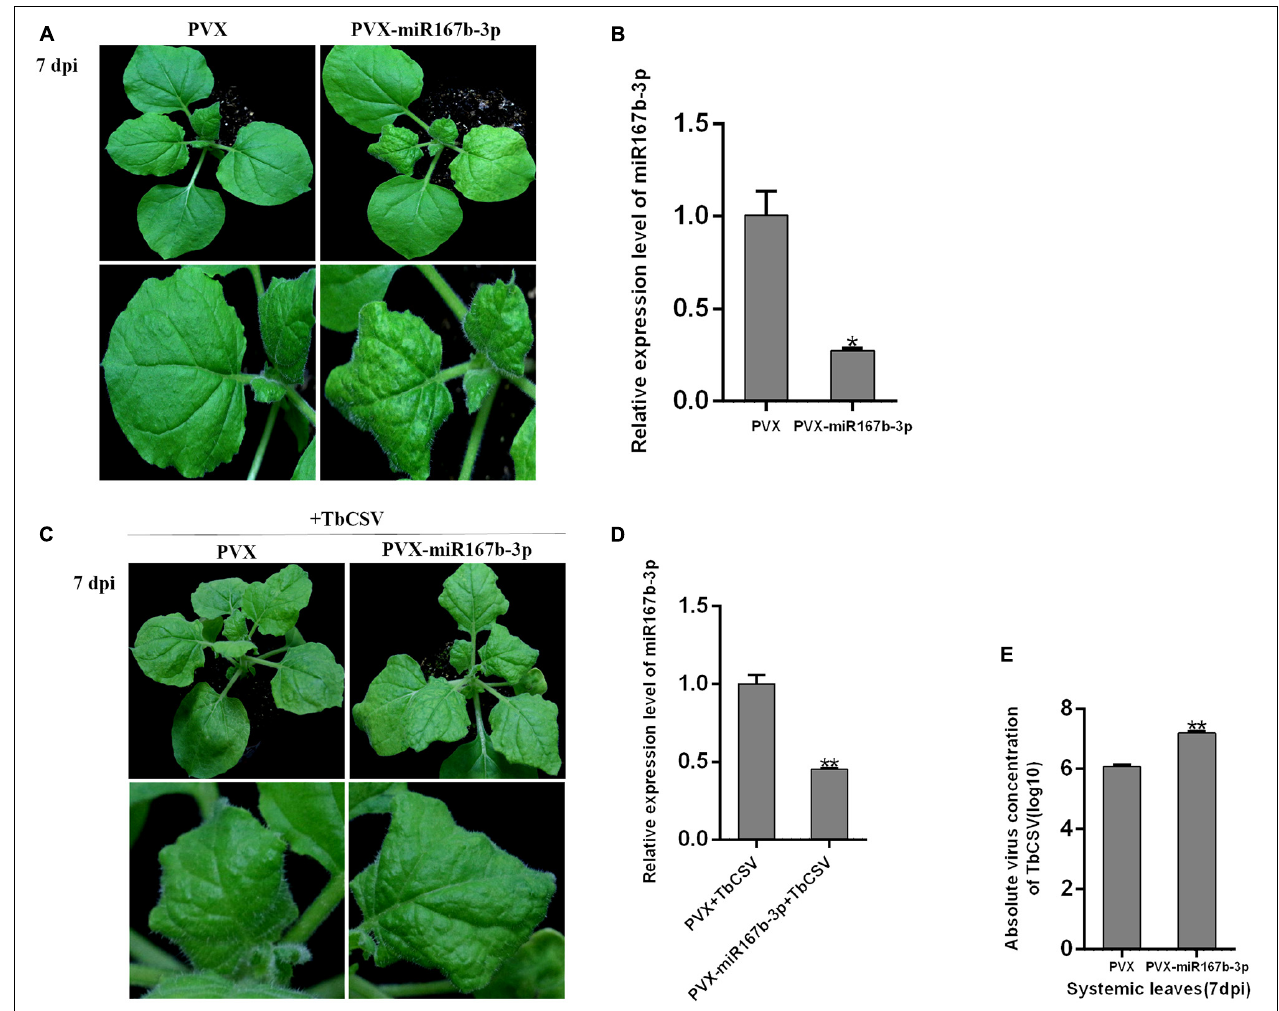
FIGURE 3 | Suppression of nbe-miR167b-3p enhanced leaf curling symptom induced by TbCSV and increased viral DNA accumulation. (A) PVX-based miRNA suppression (VbMS) system was used to down-regulate the expression of nbe-miR167b-3p. (B) Expression level of nbe-miR167b-3p in PVX-miR167b-3p-treated plants was significantly reduced compared with that in the control plants by qRT-PCR. (C) TbCSV was infiltrated into PVX-miR167b-3p-treated and control plants 7 days after VbMS treatment. (D) Relative expression level of nbe-miR167b-3p in TbCSV-infected and PVX-miR167b-3p-treated plants using qRT-PCR. (E) TbCSV DNA copy numbers in the systemic leaves harvested from the PVX plus TbCSV-inoculated plants or the PVX-miR167b-3p plus TbCSV-inoculated plants. Significance of difference between treatments (* p < 0.05; ** p < 0.01) was determined by the Student’s t -test.